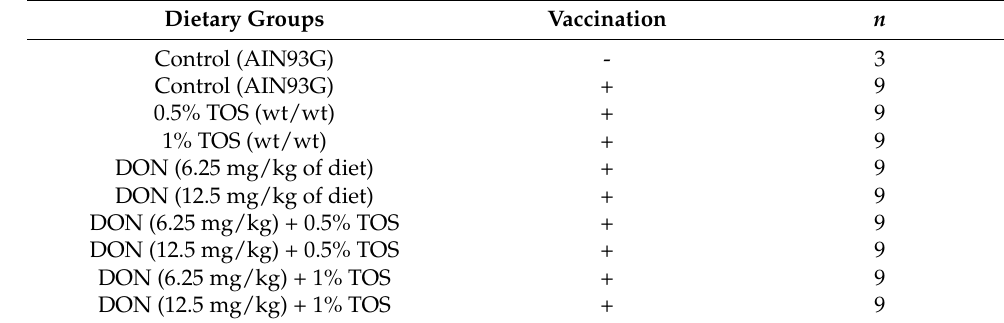
Table 1. Experimental groups, and concentrations of deoxynivalenol (DON) and trans-galacto- oligosaccharides (TOS) in the